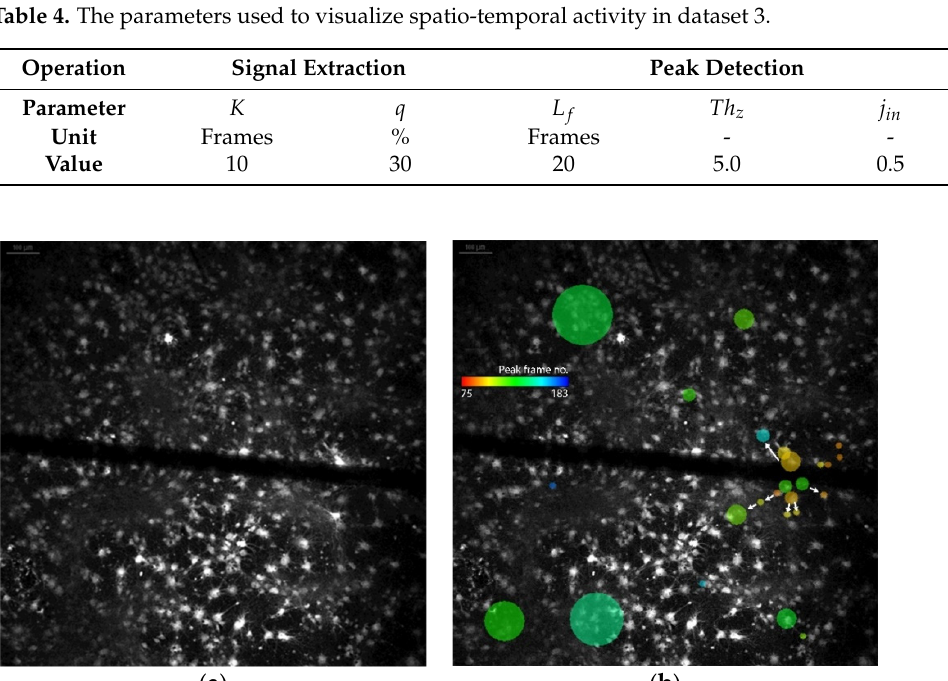
Table 4. The parameters used to visualize spatio-temporal activity in dataset 3.